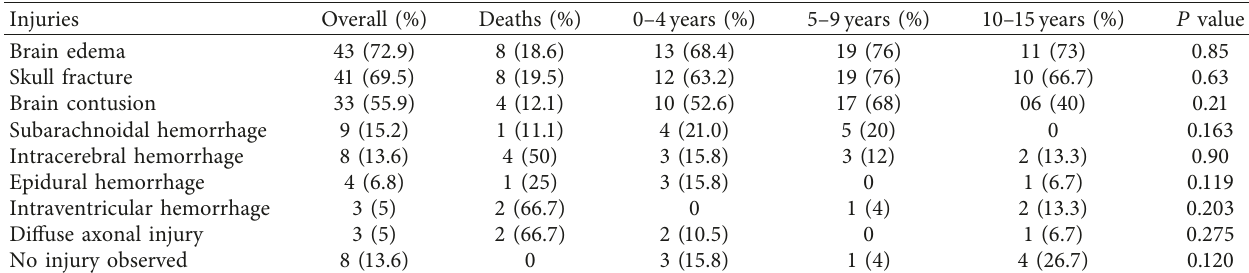
Table 2: Type and frequency of head injuries for 59 (64.8%) CT scans done.